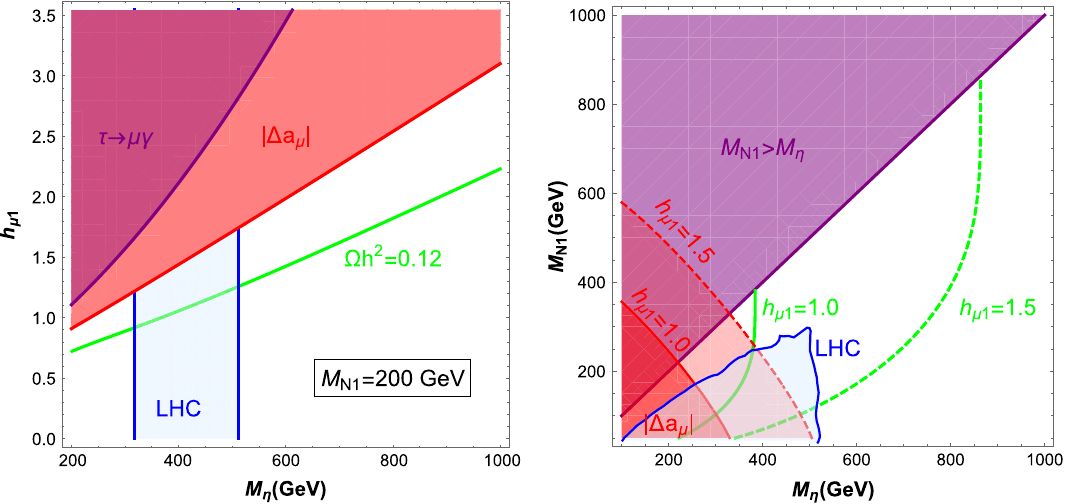
Fig. 7 Combined results for the Yukawa-portal DM. Left pattern: in the h μ 1 - M η plane; right pattern: in the M N the condition for correct relic density. And the blue regions are excluded by LHC direct search, which will be discussed in Sect.